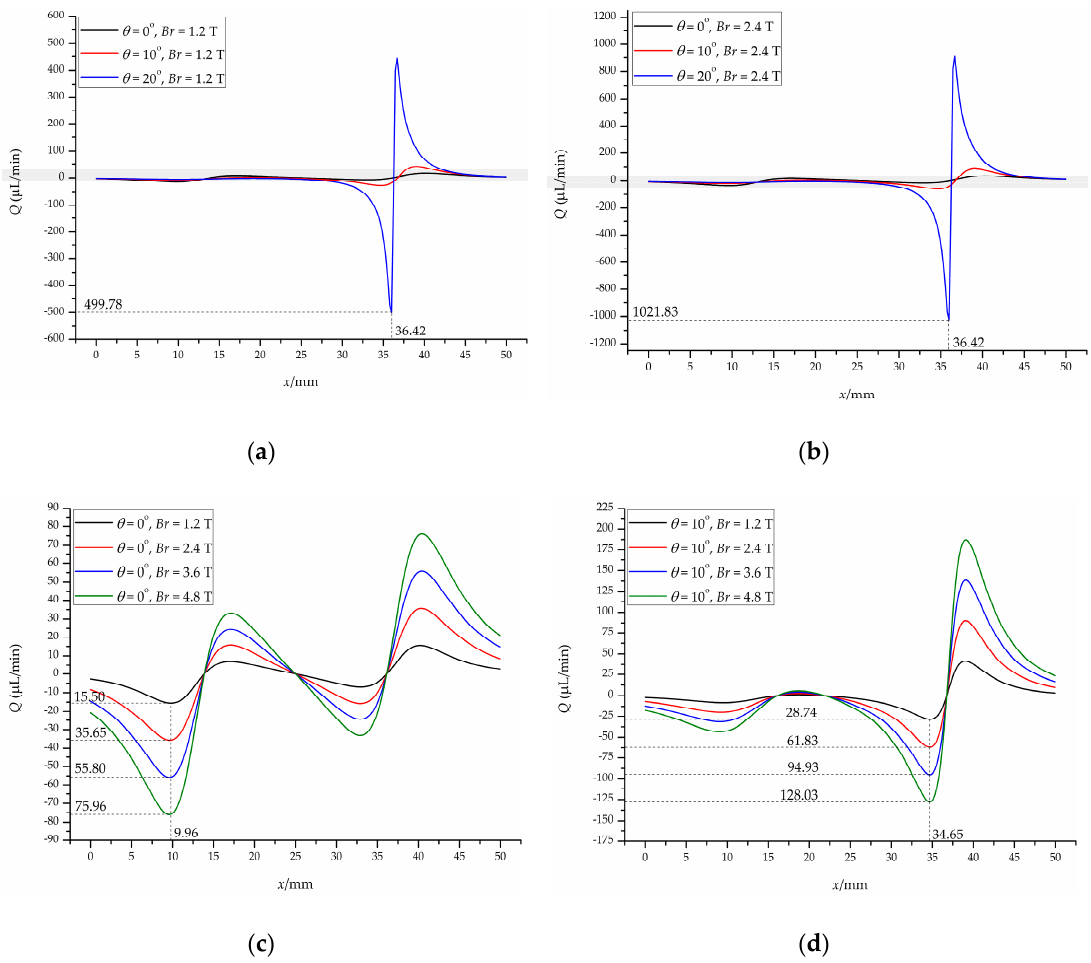
Figure 9. The threshold of magnetic field and flow field: the corresponding critical value of the permanent magnet after rotating at different angles for ( a ) Br = 1.2 T and ( b ) Br = 2.4 T; the corresponding critical value of ( c ) the vertical magnetic field and ( d ) the inclined magnetic field under different Br .